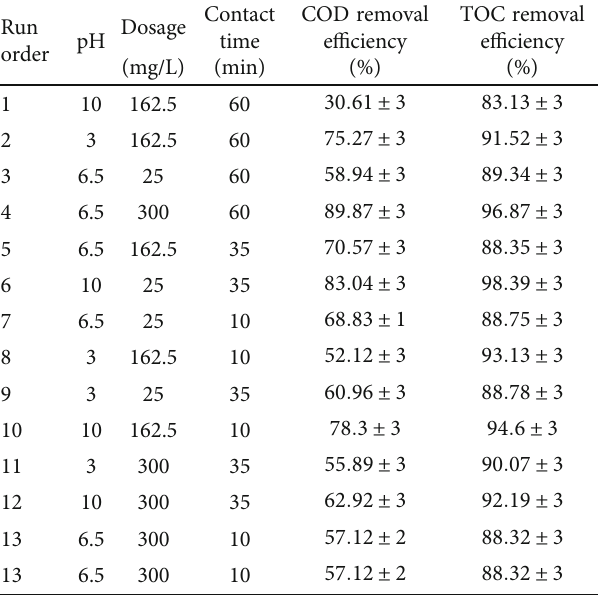
Table 2: Experimental design matrix using the RSM technique with the experimental values for COD and TOC removal e ffi ciency.